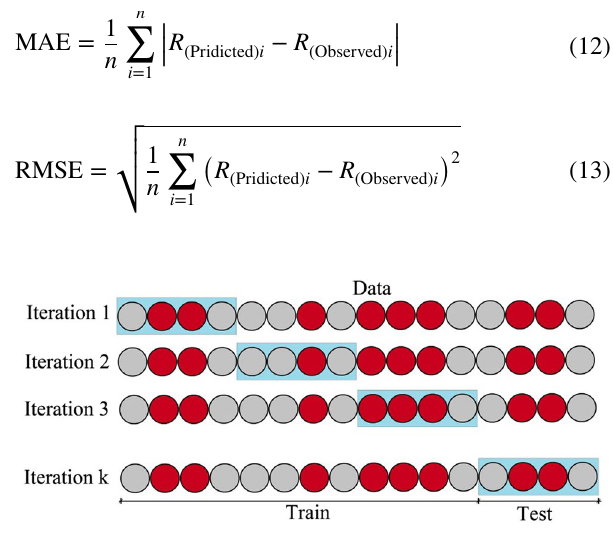
Fig. 3 Dealing of k -fold cross-validation method with experimental